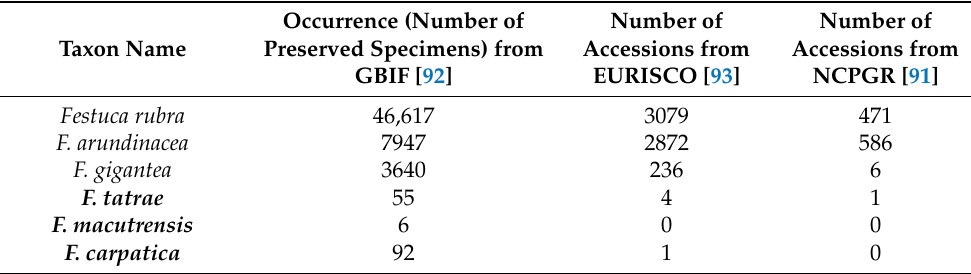
Table 3. Occurrence of selected Festuca species in repositories ex situ on the Polish and interna- tional